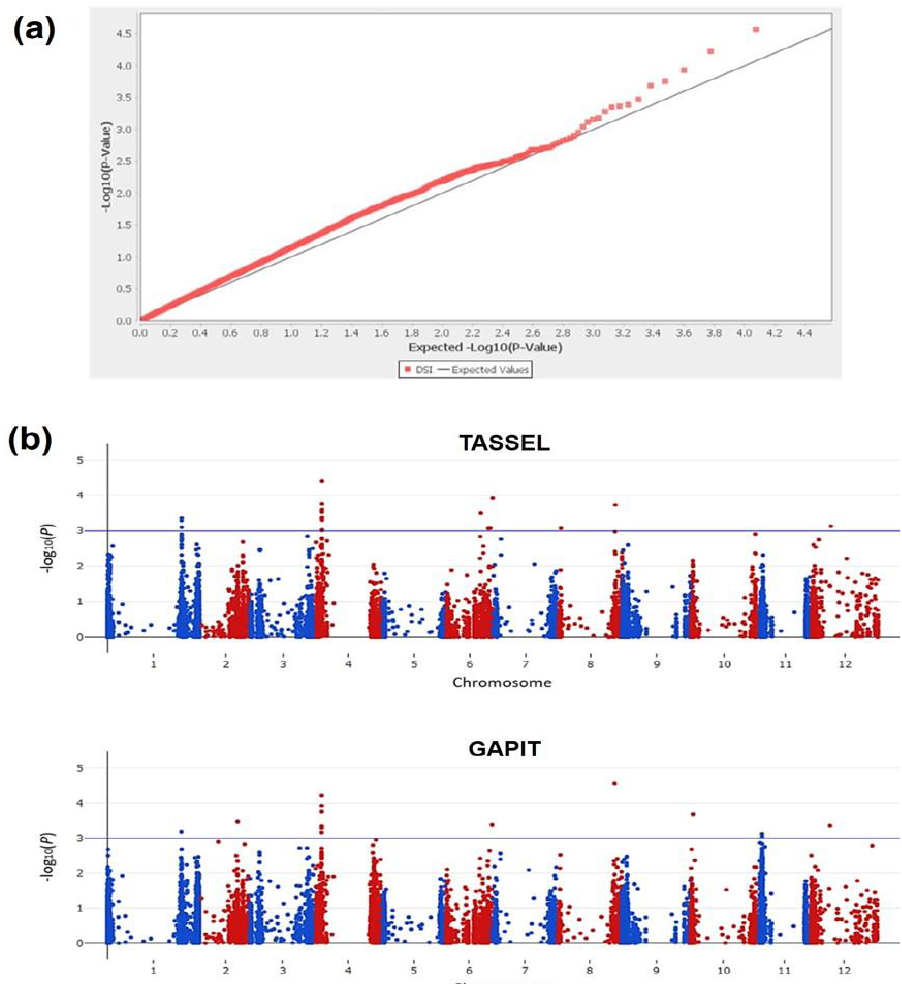
Figure 5. ( a ) Quantile-Quantile plots generated using mixed linear model (PC matrix + Kinship matrix) in TASSEL 5.0 software; ( b ) Manhattan plots generated using a mixed linear model (PC + Kinship matrix) in TASSEL ( top ) and GAPIT ( bottom ) software for a genome-wide association study carried out for 11,912 single nucleotide polymorphism (SNP) loci obtained from 244 S. lyco- persicum and 46 wild species accessions. The blue horizontal line represents −log 10 ( P ) = 3, and the SNPs above the blue line in the plot were selected as significant and highly correlated with powdery mildew resistance in tomato.